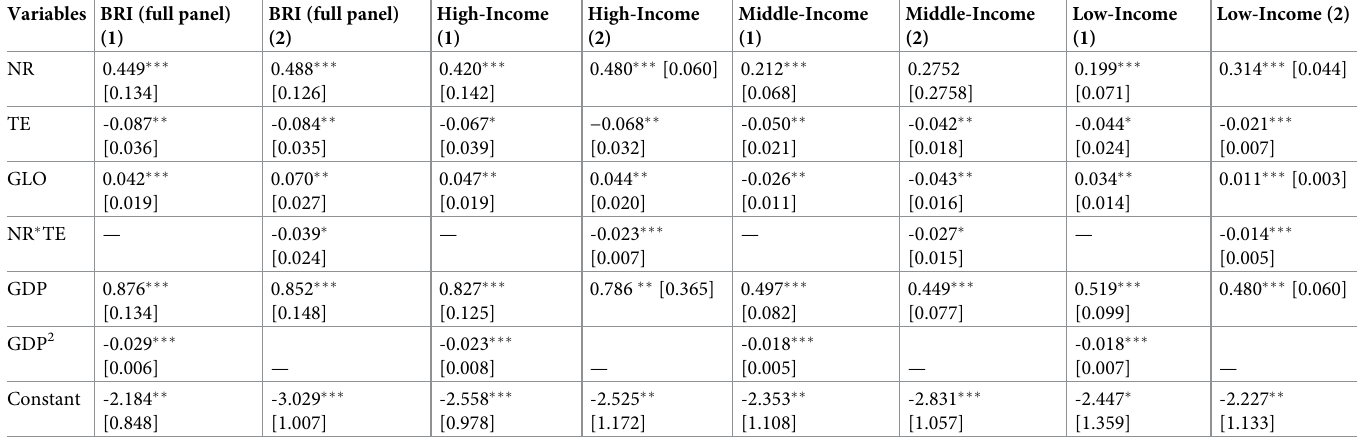
Table 5. Results of